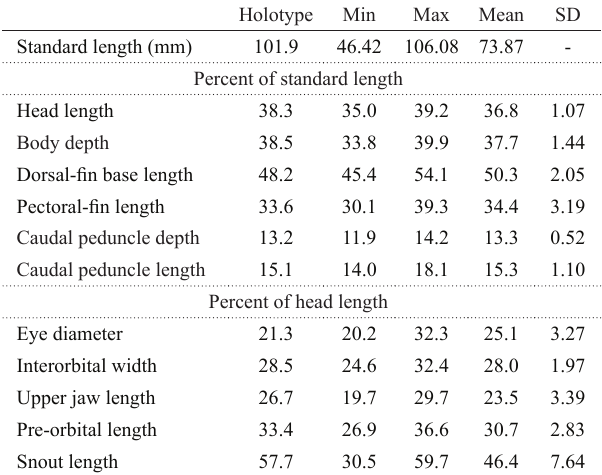
circular dots. Distal one third of anal-fin rays and spines dark brown, without additional marks. Two proximal thirds of vered with white dots, except near upper and lower